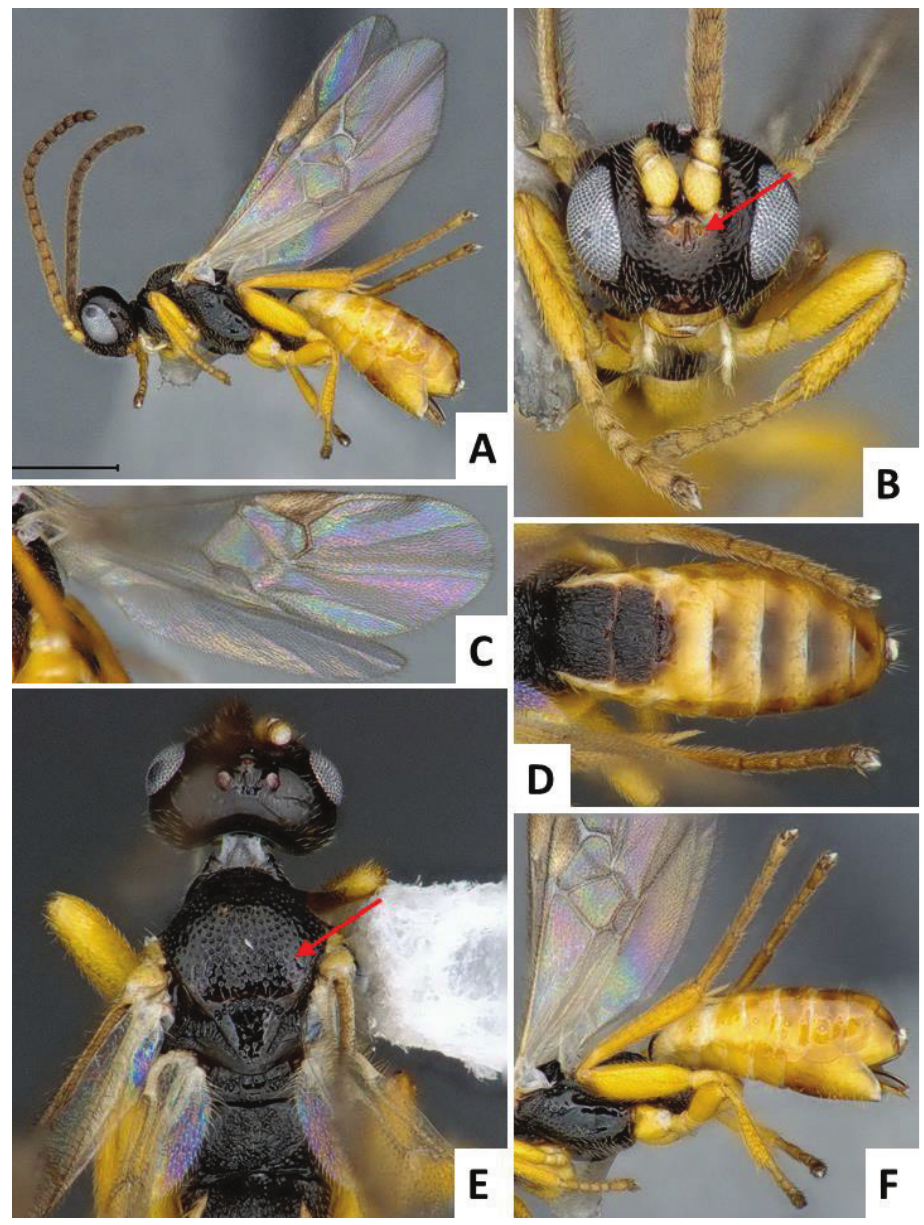
Figure 2. Cotesia typhae , paratype, female specimen from Kobodo, Kenya. A Habitus, lateral view B Head, frontal view (arrow shows face projection between antennal base) C Wings D Metasoma, dorsal view E Head and mesosoma, dorsal view (arrow shows anteromesoscutum punctures) F Metasoma, lateral